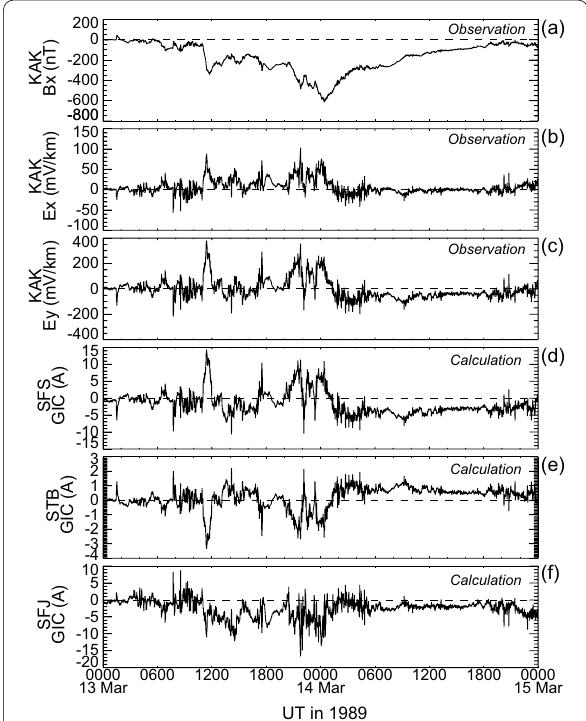
Fig. 6 a x -component of observed geomagnetic disturbances at Kakioka; b , c observed geoelectric disturbances E x and E y at Kakioka; d calculated GIC at SFS; e calculated GIC at STB, and f calculated GIC at SFJ on 13–14 March